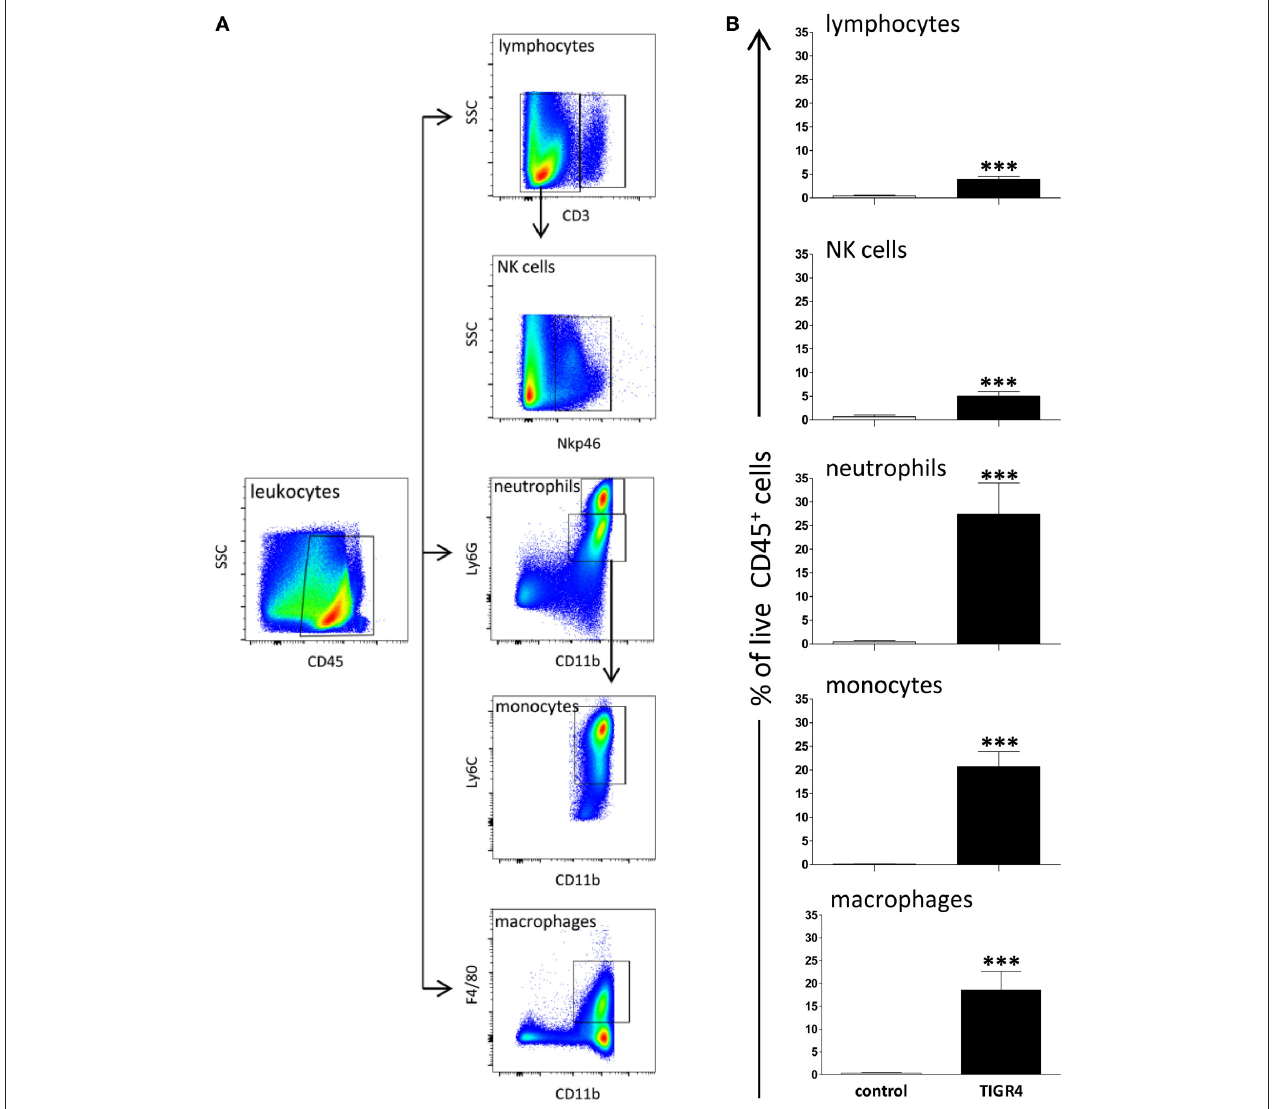
FIGURE 3 | Leukocytes in the brain 48h post infection. The recruitment of leukocytes was quantified by multiparametric flow cytometric analysis in the brains of C57BL/6J mice collected 48h post intracranial infection with 3 × 10 4 CFU of S. pneumoniae TIGR4. As control, a group of mice was injected with bacterial growth medium. (A) Gating strategy adopted for the identification of leukocyte populations in brain of mice. Lymphocytes (CD45 hi CD3 + ), NKs cells (CD45 hi CD3 − NKp46 + ), neutrophils (CD45 hi CD11b hi Ly6G + ), monocytes (CD45 hi CD11b hi Ly6G − Ly6C + ), and macrophages (CD45 hi CD11b hi F4/80 + ) were detected. (B) Percentages (%) of cell populations detected in brain of mice infected with S. pneumoniae TIGR4 or injected with bacterial growth medium. Infection with TIGR4 induced the entry in the brain of about 4% lymphocytes, 5% NK cells, 27% neutrophils, 21% monocytes, and 19% macrophages, all evaluated on CD45 + cells. In control group all cell populations detected were ≤ 0.7% of CD45 + cells. Data are from four independent experiments with 3–6 animals/group. Bars represent mean ± SEM. Two tailed Mann-Whitney test was used for comparison between infected and control group and asterisks indicate statistical significance ( *** P <